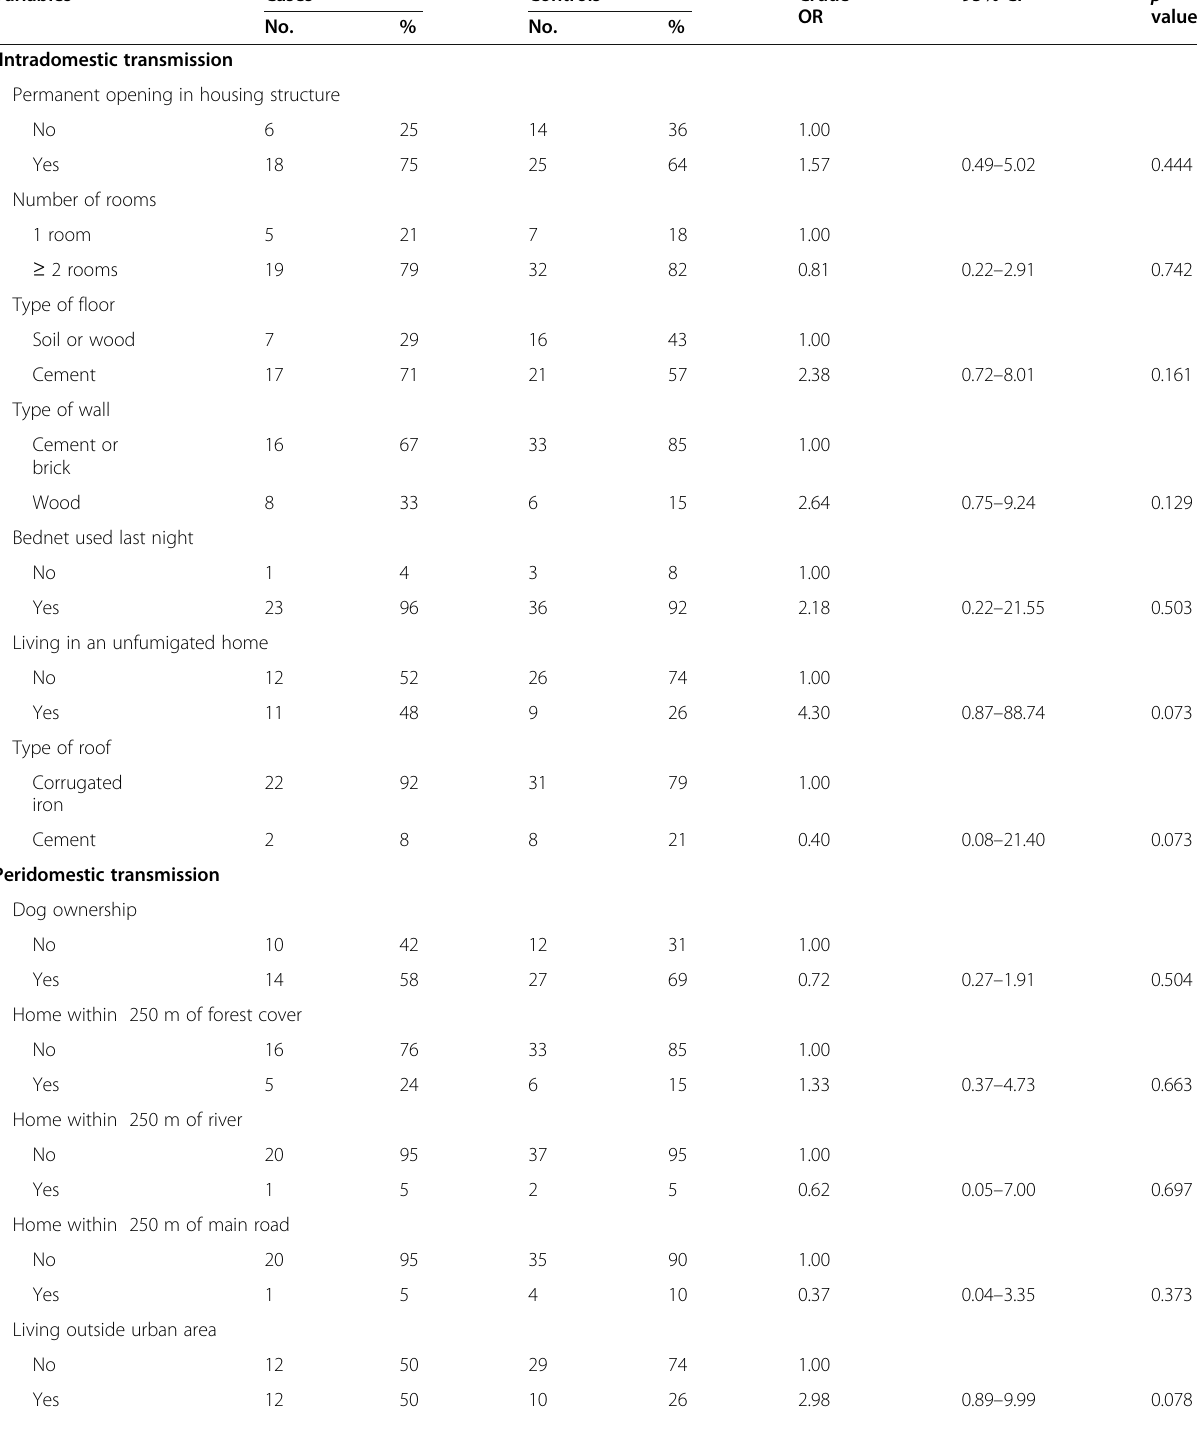
Table 1 Crude odds ratios (OR) and their 95% confidence intervals (95% CI) for the association between Leishmania spp. infection for variables associated with intradomestic, peridomestic, and non-domestic CL transmission, Alto Mayo, Peru 2014 – 2016 Variables